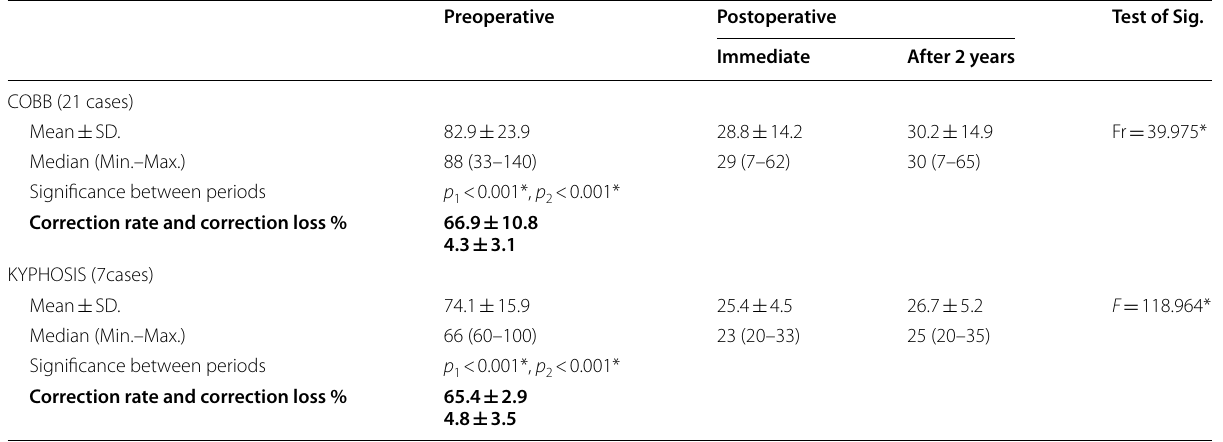
Correction rate and loss are bold because as they are the most important information in the table F : F test (ANOVA) with repeated measures, significance between periods was done using post hoc test (adjusted Bonferroni) Fr: Friedman test, Sig. bet. periods was done using post hoc test (Dunn’s)